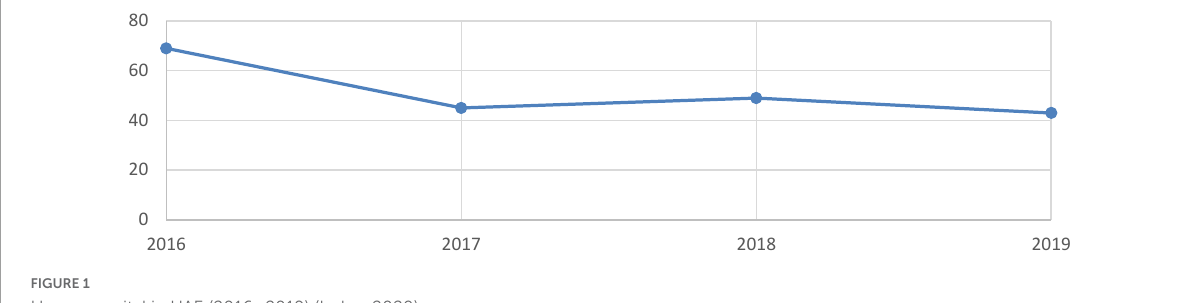
FIGURE1 Human capital in UAE (2016–2019) (Index, 2020).